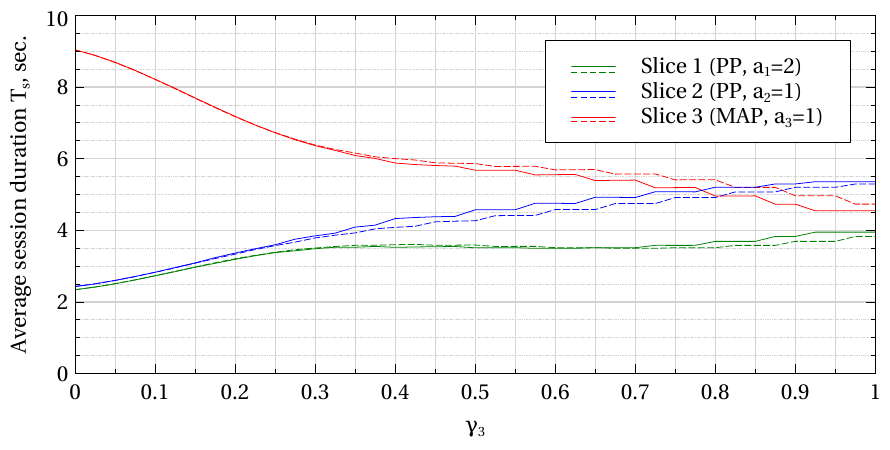
Figure 6. The average session duration T s vs. γ 3 ; γ 2 = α − γ 3 lines— α =